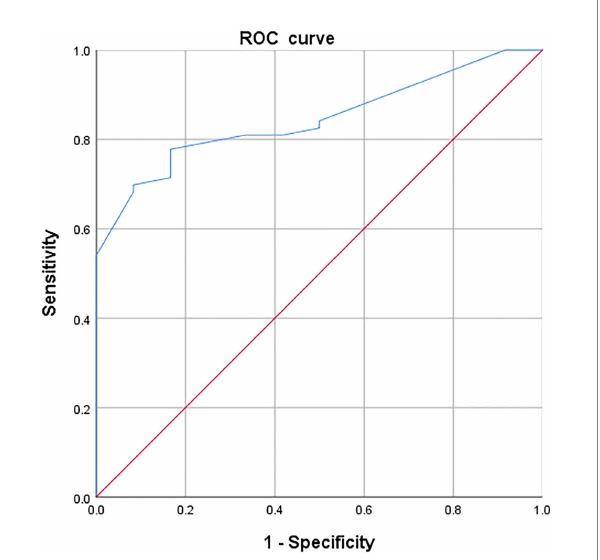
FIGURE 1 Receiver-operating characteristic (ROC) curve of EQ-5D-5L HSU change score in patients whose health states